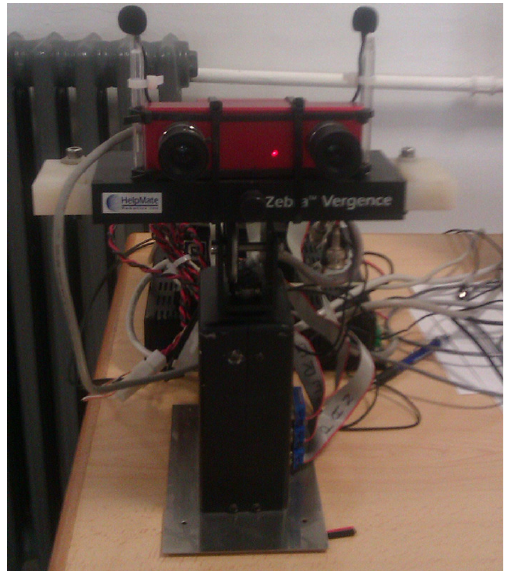
Figure 5. Stereo vision and binaural set-up mounted on the motorized head used for the